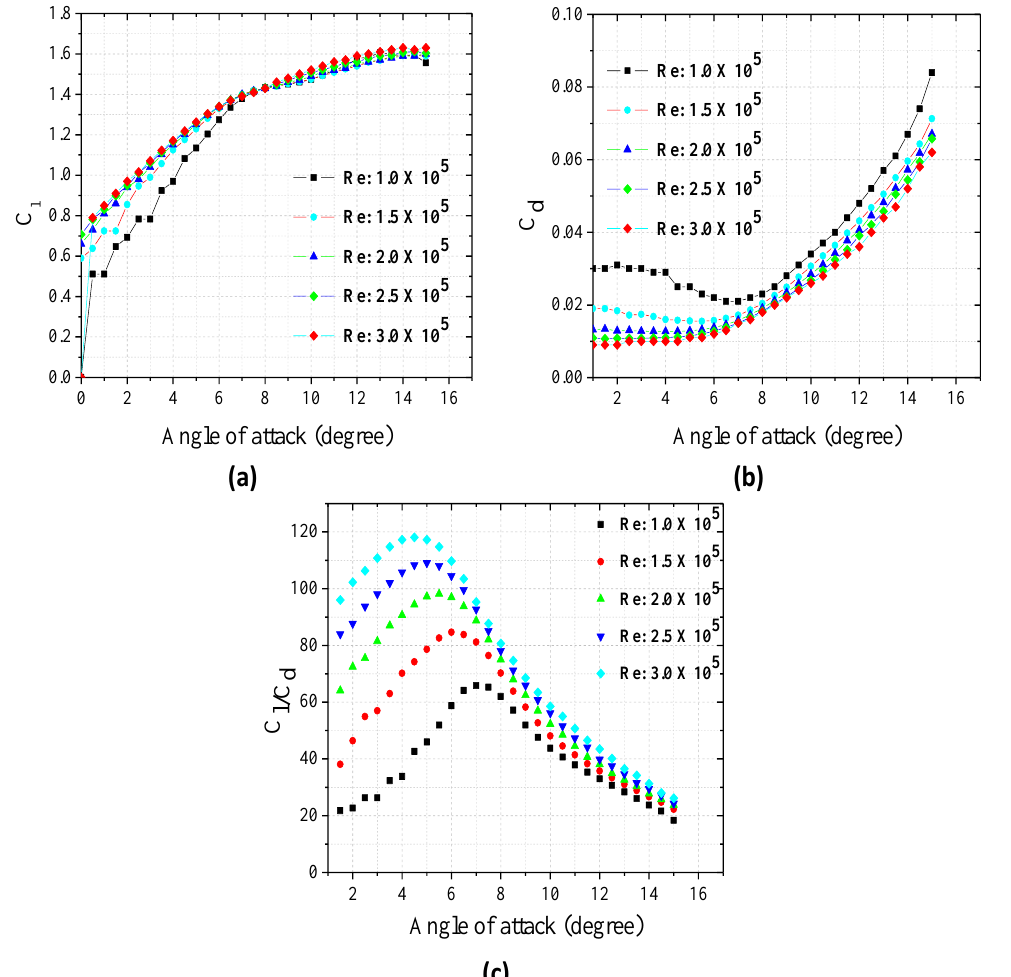
Figure 4. SG6043 airfoils ( a ) lift coefficients; ( b ) drag coefficients; ( c ) lift-to-drag ratio at the various angle of attack.